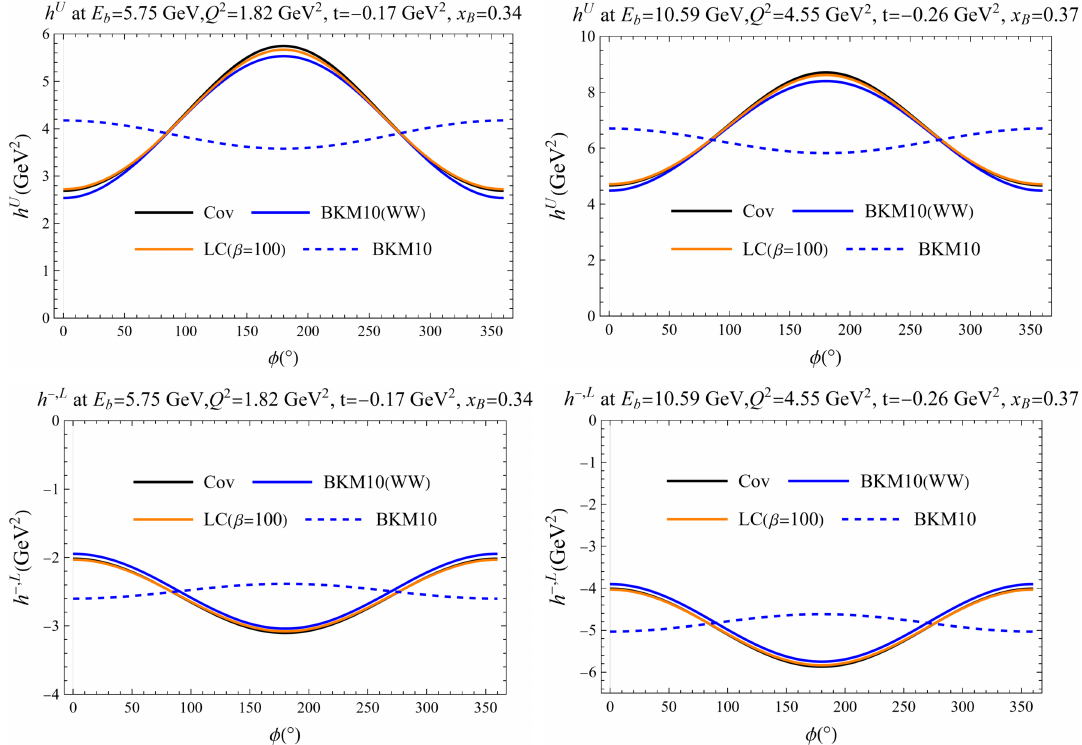
Figure 11 . A comparison of the coefficients h U and h − , L over different formulas. In the plots, we can see that the covariant coefficients above agrees well with the BKM10 results with WW relations and also our light cone calculation with β → ∞ , while they differ a lot from the result without WW relation. Note that in the β → ∞ limit, the value α is actually degenerate and